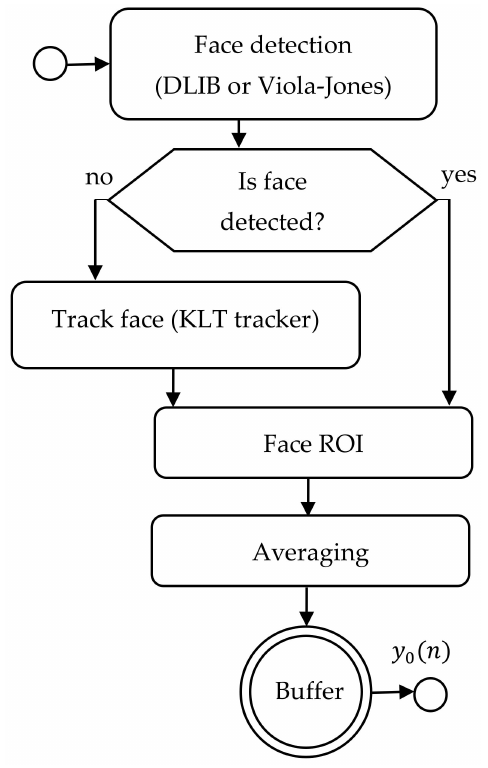
Figure 1. Face detection and tracking—algorithm outline.